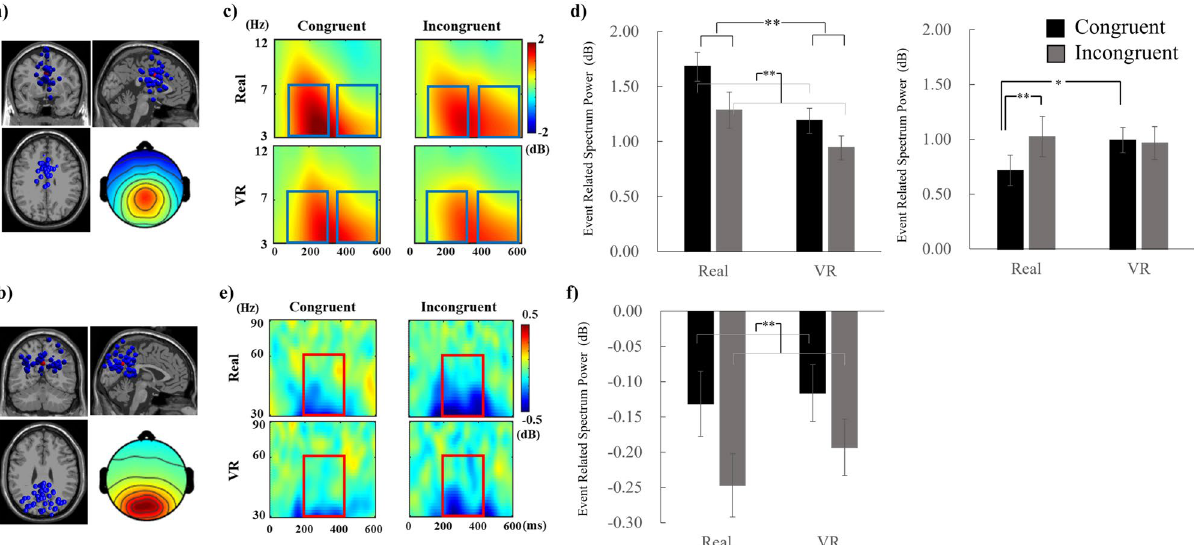
Figure 6. ( a ) Dipole locations of all components (blue) involved in the precentral cluster and the centroid of all dipole positions (red) and the topographical map on the scalp averaged across all components. ( b ) Dipole locations of all components (blue) involved in the parietal cluster and the centroid of all dipole positions (red) and the topographical map on the scalp averaged across all components. ( c ) ERSPs at the theta and alpha bands (3–12 Hz) for each condition, averaged across all ICs obtained from all participants involved in the parietal cluster. The upper and lower rows provide the ERSPs obtained in the real and VR environments, respectively. ( d ) Bar plots of the averaged ERSP values of the theta band (3–7 Hz) at 100–300 ms (left) and 400–600 ms (right) for each condition. ( e ) ERSPs at the gamma band (30–90 Hz) for each condition, averaged across all ICs obtained from all participants involved in the parietal cluster. The upper and lower rows provide the ERSPs obtained in the real and VR environment sessions, respectively. ( f ) Bar plot of the averaged ERSP values of the gamma band (30–60 Hz) during the target period (200–400 ms) for each condition. * p < 0.05, ** p <